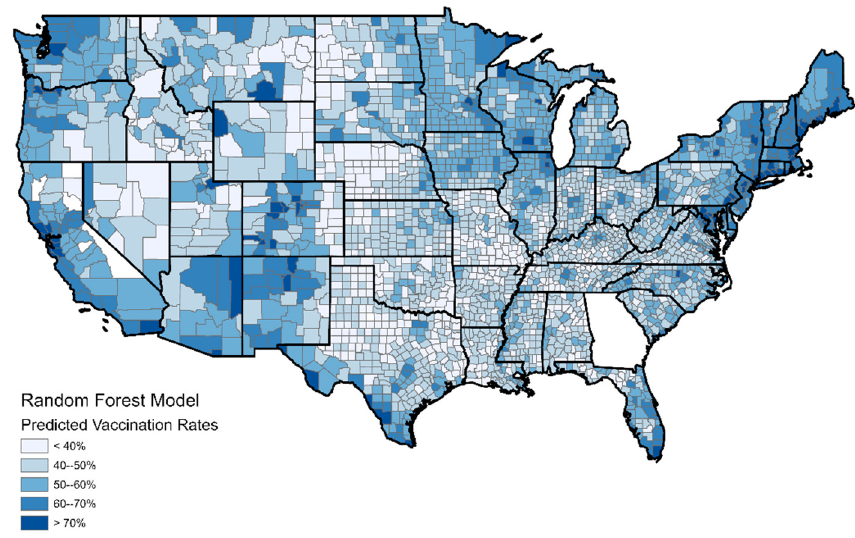
Figure 7. Predicted vaccination rates by county according to the random forest model.